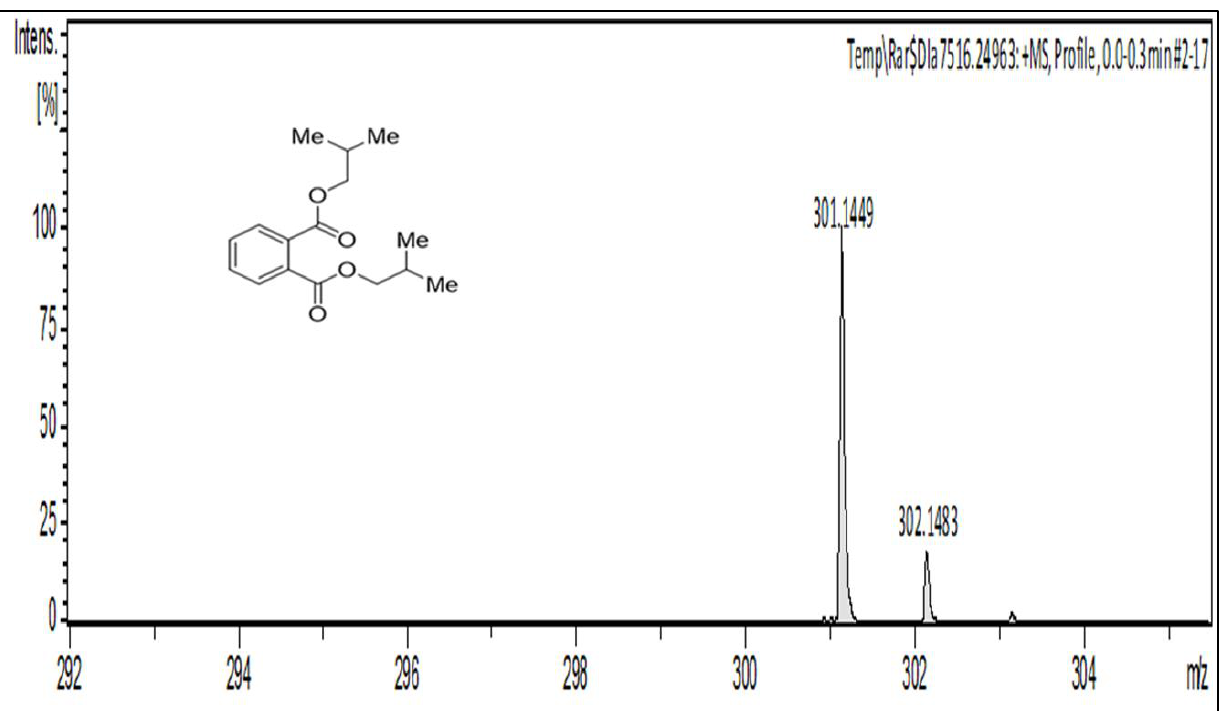
Figure 6. The HR-MS (high-resolution mass spectrometry) chromatogram of BDCe fraction isolated from Obea of O. bracteata.